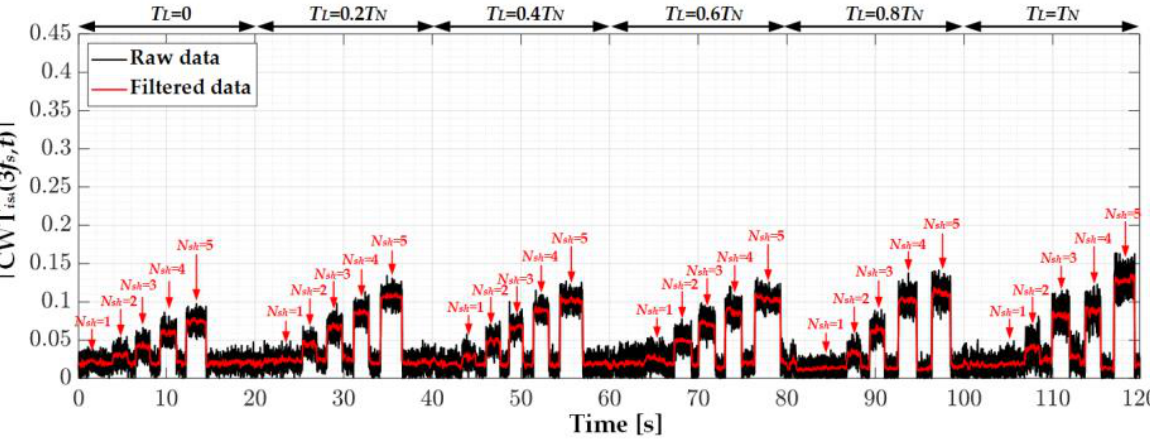
Figure 7. The raw and filtered waveforms of the |CWT isA (3 f s , t )| value during the cyclic momentary short-circuiting of 1 to 5 turns and different load torque levels ( T L = var, f s = f sN = 100 Hz). The presentation of the results of the CWT analysis, including the frequency and colormap range, for the remaining diagnostic signals will be retained. Figure 8 shows 2D and 3D scalograms of the stator phase current envelope signal. For this signal, the increase in the values of the CWT coefficients related to the second harmonic, the 2 f s component |CWT isH A (2 f s , t )|, is